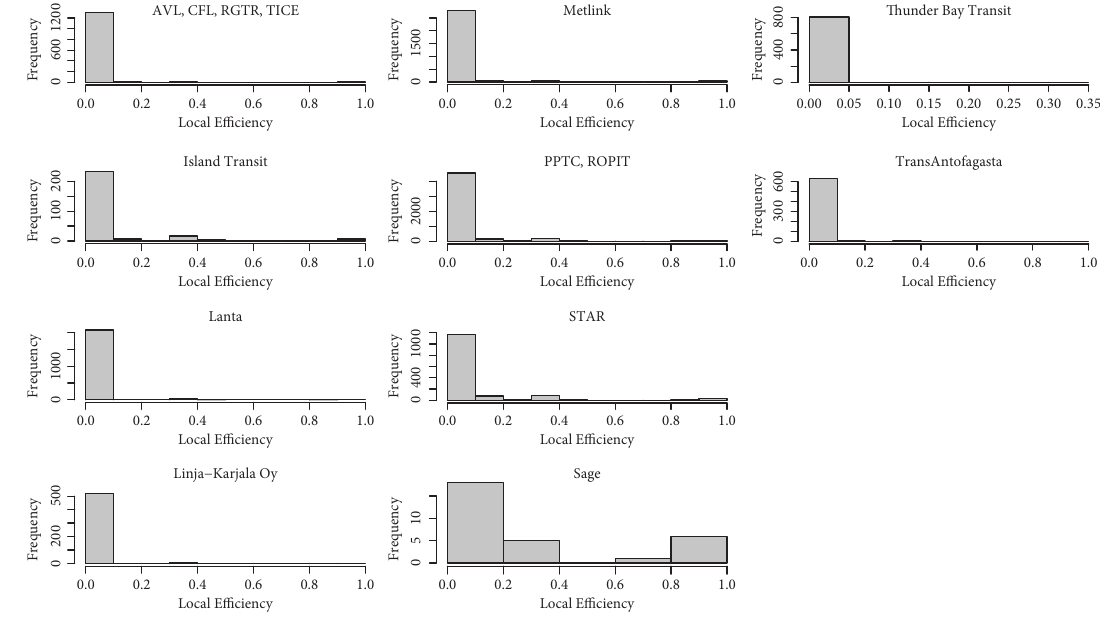
Figure 3: Histogram of local